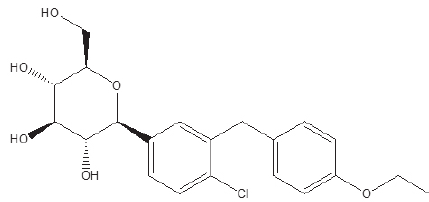
FIGURE 2 - Chemical structure of